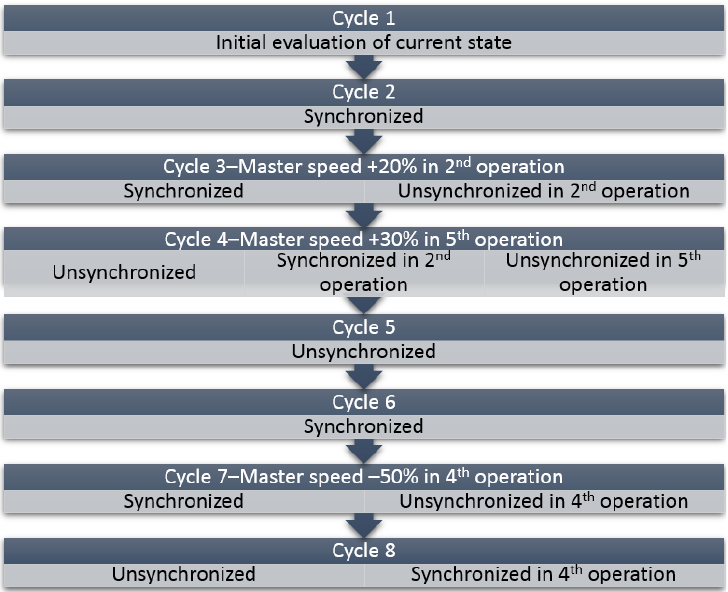
Figure 5. Percentage proportion deviation without feedforward synchronization — Experiment 1a.